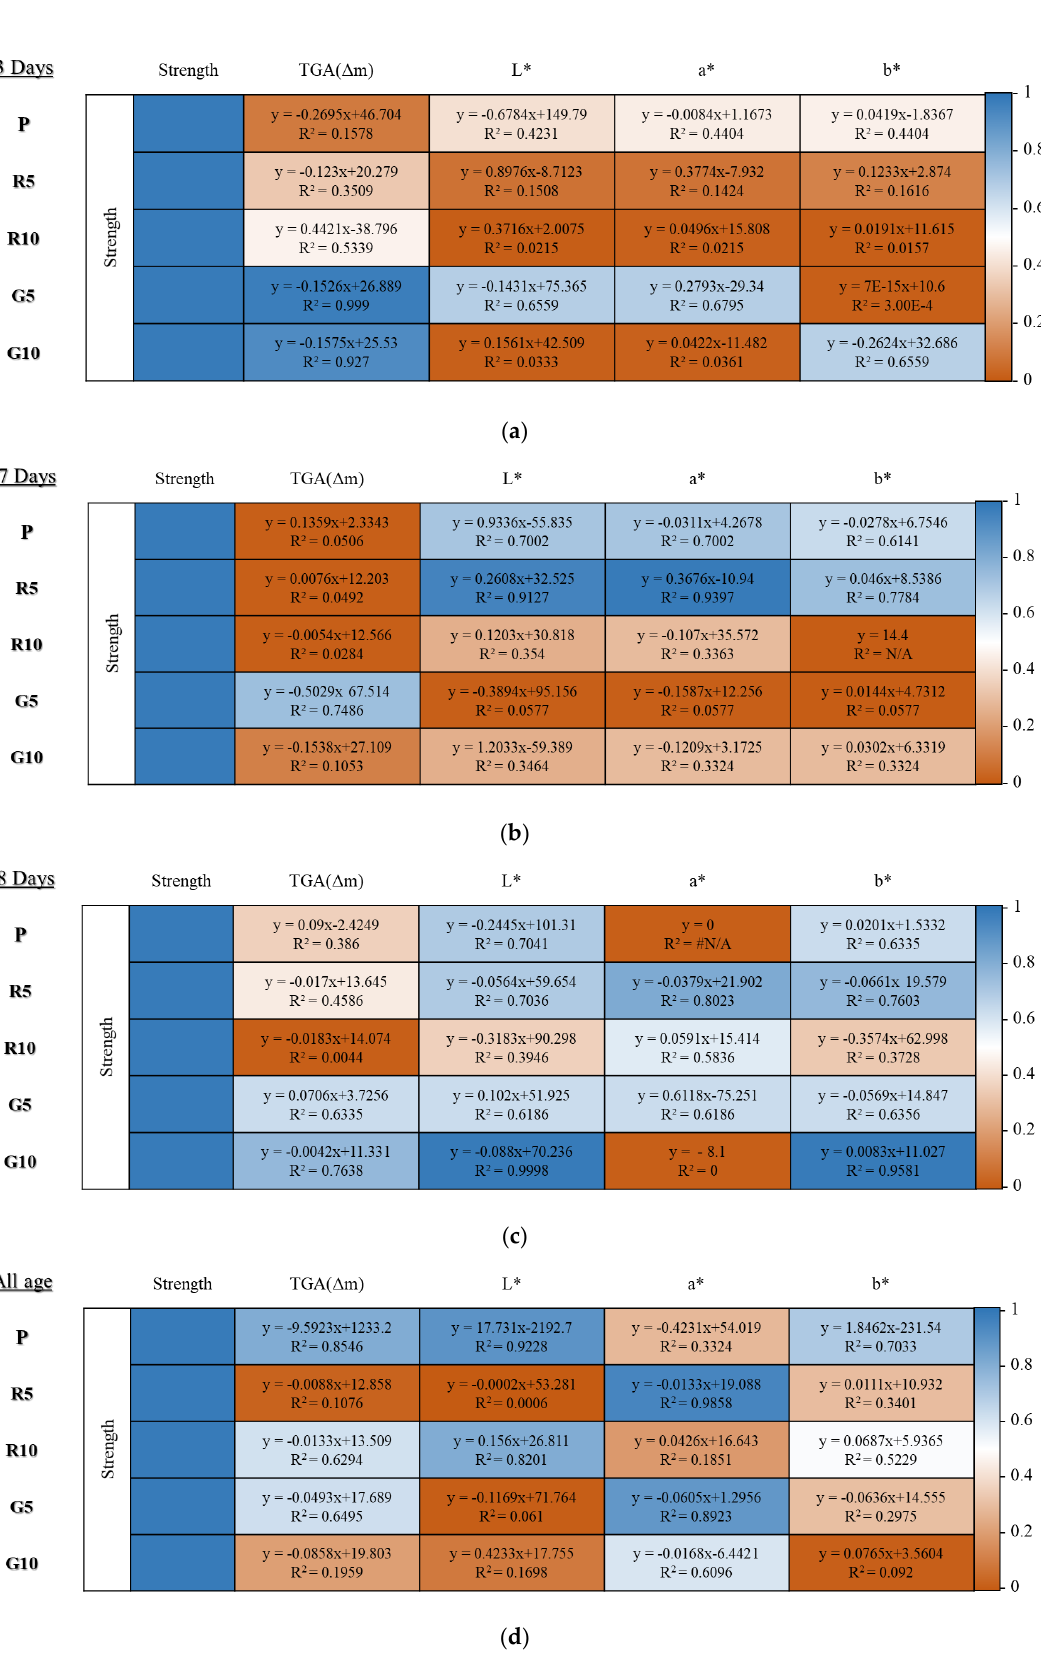
Figure 9. Correlation analysis matrices of HSCCs at different ages, showing the R 2 of specific factors measured at ( a ) 3 days, ( b ) 7 days, ( c ) 28 days, and ( d ) all ages (3–28